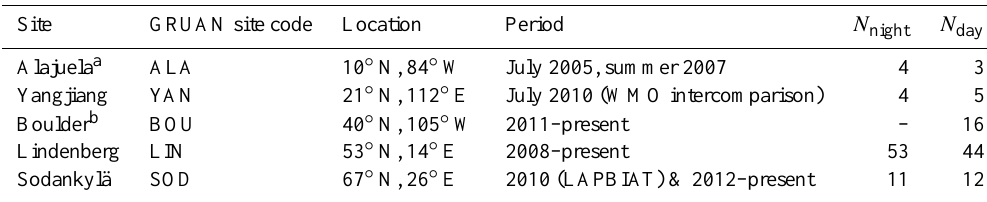
Table 6. Overview of RS92-CFH dual soundings used in the comparison.